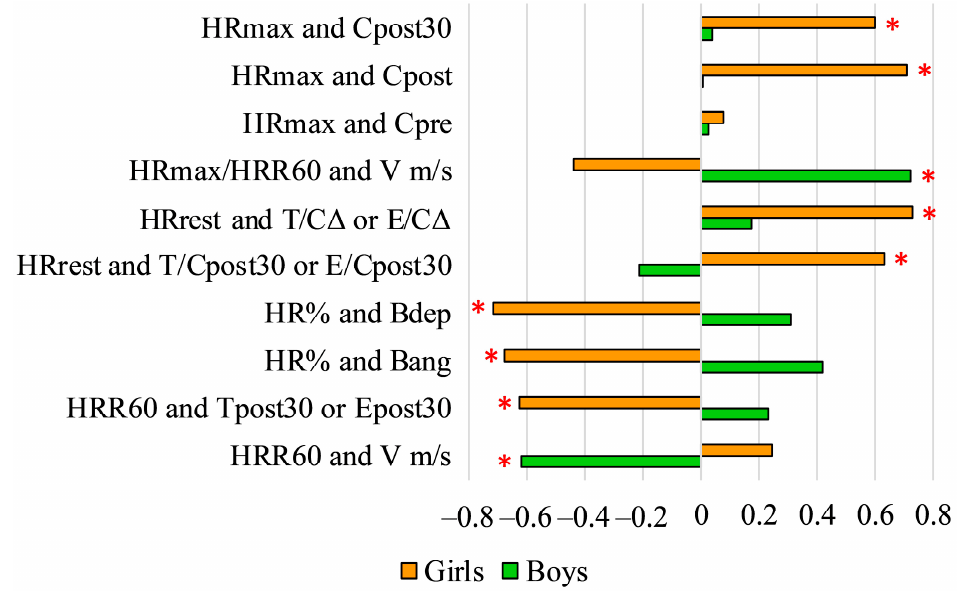
Figure 3. Pearson’s correlation coefficient (r) values of HR variables and other psychological and physiological variables (* p < 0.05). HRmax: maximal heart rate during the maximal exercise; Cpost30: cortisol levels 30 after the field test; Cpost: cortisol levels after the field test; Cpre: cortisol levels before the field test; HRmax/HRR60: ratio of maximal heart rate during the 200 m maximal freestyle swimming and the difference between the heart rate at the end of the 200 m freestyle swimming and 60 s later; V m/s: average speed of the swimmers’ during the 200 m maximal freestyle swimming; HRrest: resting heart rate; T/C ∆ : difference of testosterone-cortisol ratio before the field test and 30 min after the field test; E/C ∆ : difference of estradiol-cortisol ratio before the field test and 30 min after field test; T/Cpost30: testosterone/cortisol ratio 30 min after the field test; E: estradiol; E/Cpost30: estradiol/cortisol ratio 30 min after the field test; HR%: the ratio of and the athletes’ calculated possible maximal heart rate and maximal heart rate during the maximal exercise; Bang: score of anger on the BRUNEL scale; HRR60: difference between the heart rate at the end of the 200 m freestyle swimming and 60 s later; Tpost30: testosterone levels 30 min after the field test; Epost30: estradiol levels 30 min after the field test.